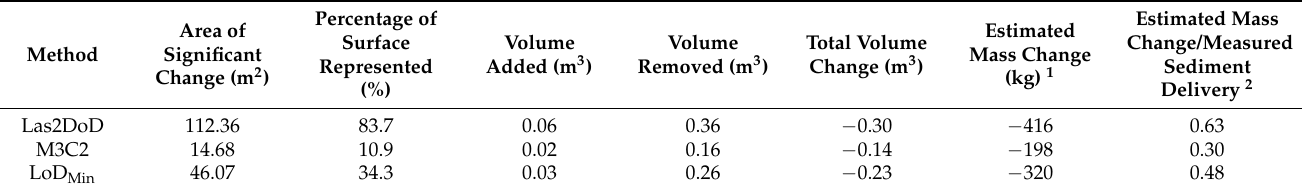
Table 2. Results from applying the three change detection methods in comparison with the plot measurements for Plot B.